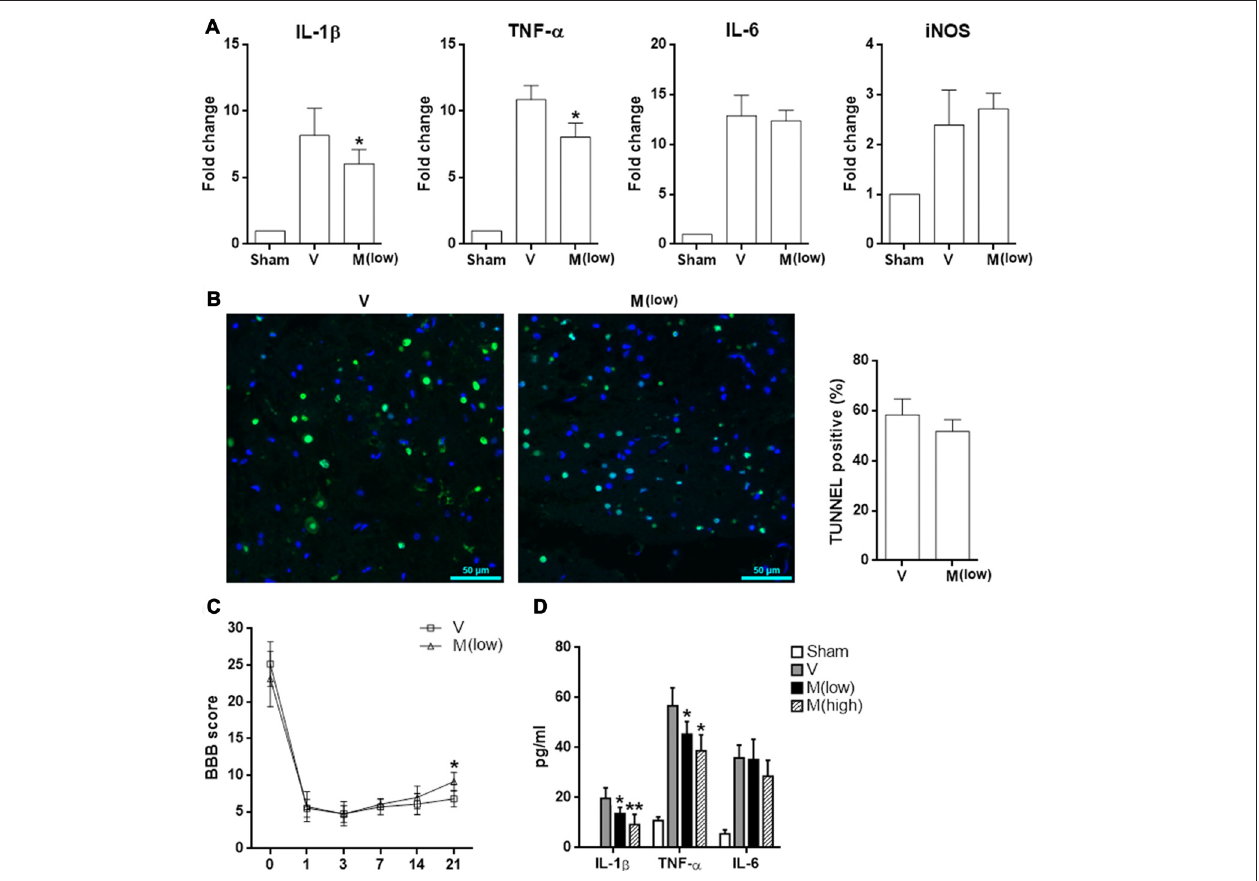
FIGURE 8 | Effect of low dose of methylene blue on SCI. Rats received methylene blue at a lower dosage (2 mg/kg body weight) before and after SCI. (A) mRNA levels of indicated pro-inflammatory mediators in T12 spinal cord 6 h after SCI. N = 3 per group. (B) TUNEL staining indicating cell apoptosis in spinal cords 24 h post SCI. Left panel: fluorescent images. Right panel: statistics of TUNEL-positive cells. N = 4 per group. (C) BBB score. N = 6 per group. (D) Concentrations of indicated cytokines in T12 spinal cord lysates 6 h post SCI. N = 3 per group. V: vehicle; M (low): methylene blue at low dose; M (high): methylene blue at high dose. ∗ p < 0.05; ∗∗ p < 0.01 in comparison with vehicle